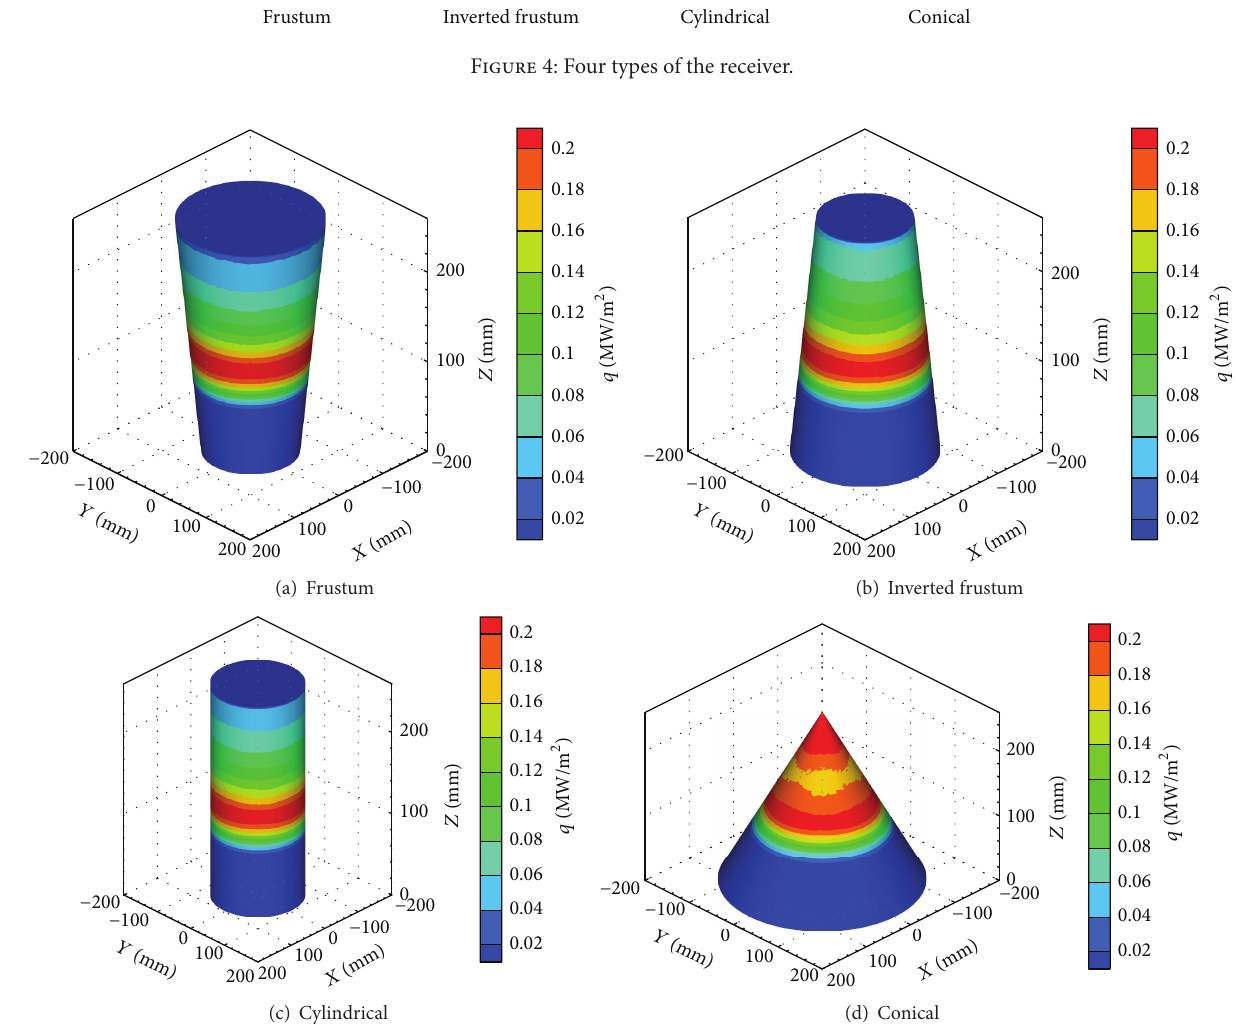
Figure 5: Radiation flux distribution based on equal area-height